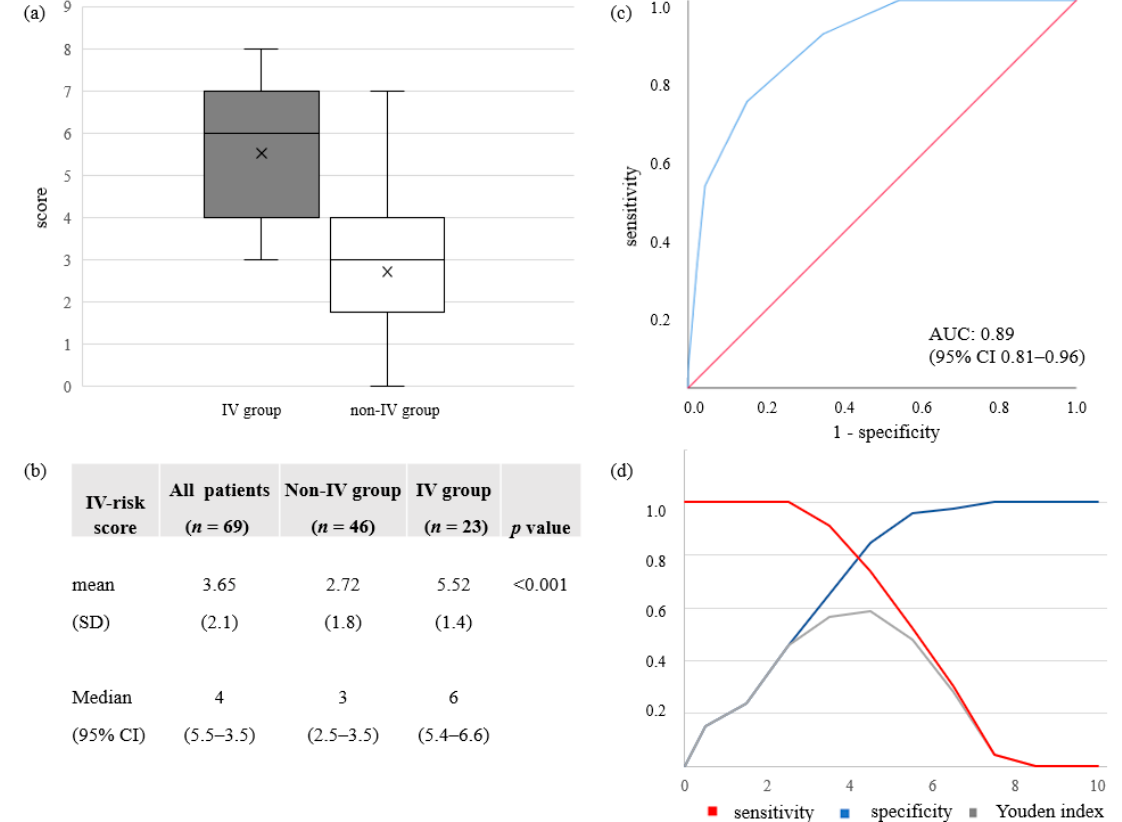
Figure 4. On admission CT IV-risk score analysis. ( a )/( b ) Descriptive statistics for the developed IV-risk score for IV-group and non-IV-group with mean (SD) and median (95% CI). ( c ) ROC curve for the diagnostic ability of IV-risk score to differentiate between IV and non-IV-groups on admission CT. In ROC analysis the AUC for the diagnostic probability for IV therapy during hospitalization was 0.89 (95% CI 0.81-0.96). ( d ) Sensitivity, specificity and Youden indices are displayed for different IV-risk scores. Optimal cut-off value based on a maximized Youden index was an IV-risk score of 5 with a sensitivity of 0.81 and a specificity of 0.85. An IV-risk score of 4 resulted in a sensitivity of >0.9 and a specificity of >0.65.